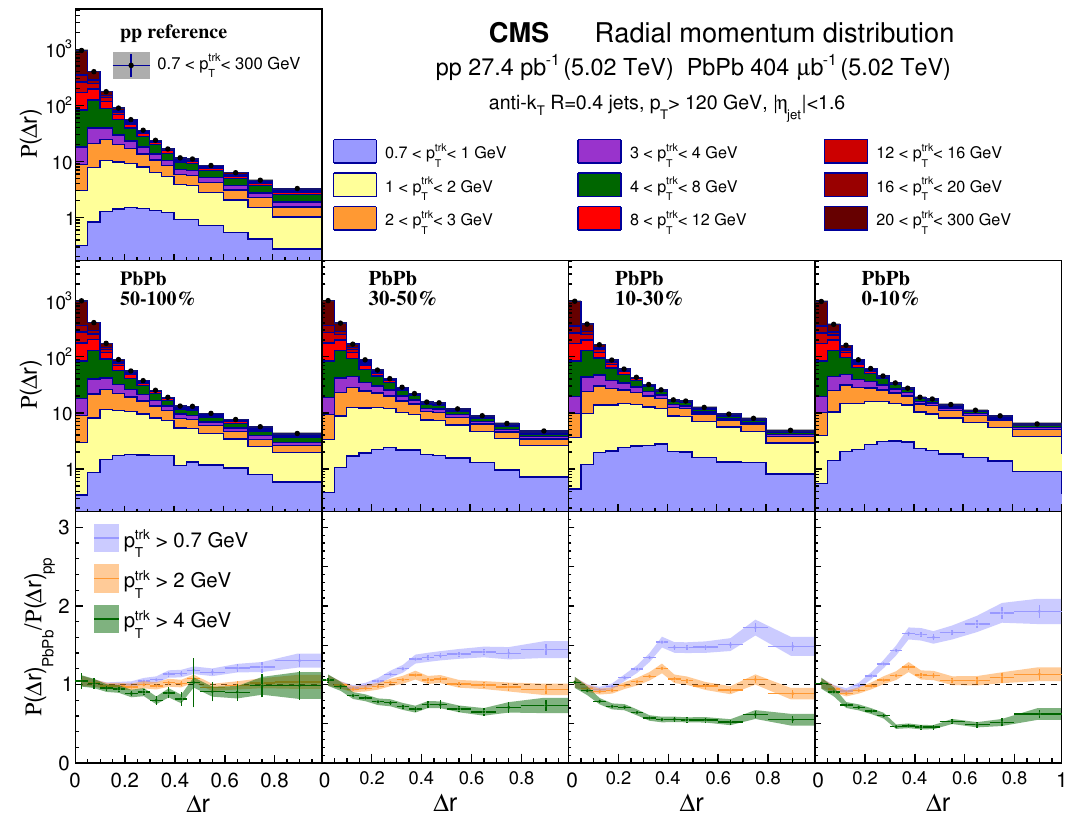
Figure 5 . The radial jet momentum distribution P((cid:1)r) of jets in pp (top left) and PbPb (middle row) collisions. The PbPb results are shown for di(cid:11)erent centrality regions. The bottom row shows the ratio between PbPb and pp data for the indicated intervals of p trk total systematic